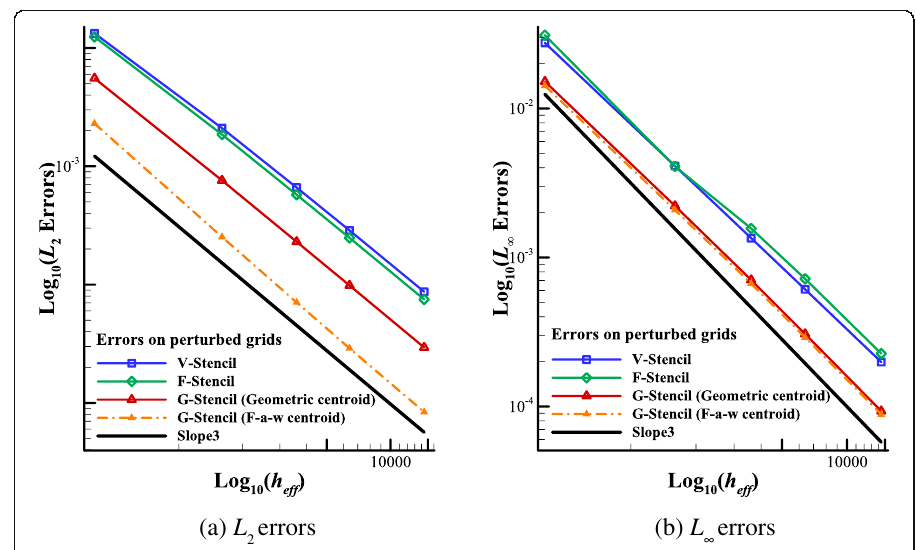
Fig. 40 ( a ) L 2 and ( b ) L ∞ errors. Errors of different stencils on randomly perturbed triangular grids with AR =5×10 2